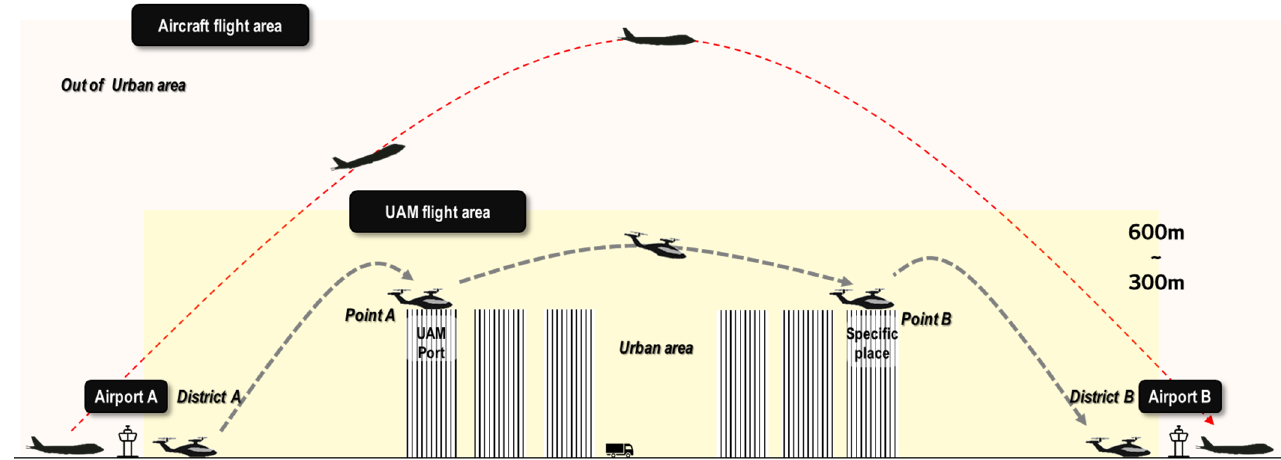
Figure 1. Flight routes of aircraft and UAM vehicles.